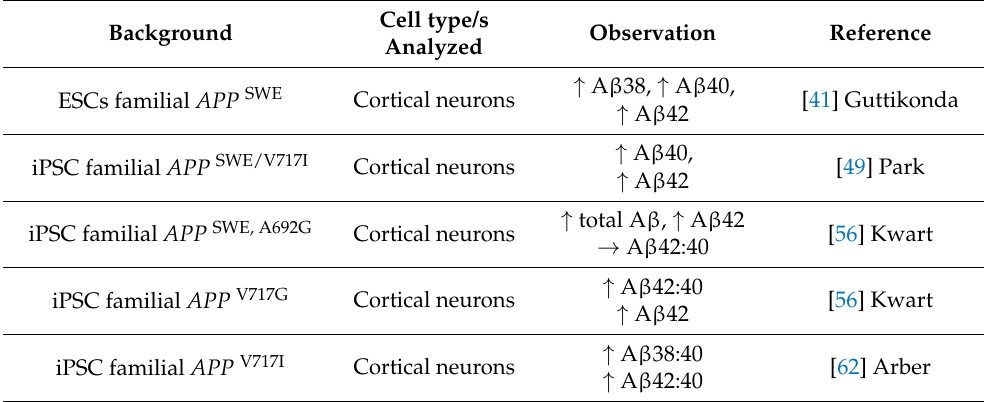
Table 1. Overview of amyloid beta (A β ) pathology modelled in AD-iPSCs harboring either familial mutations, sporadic mutations or from late-onset sporadic AD